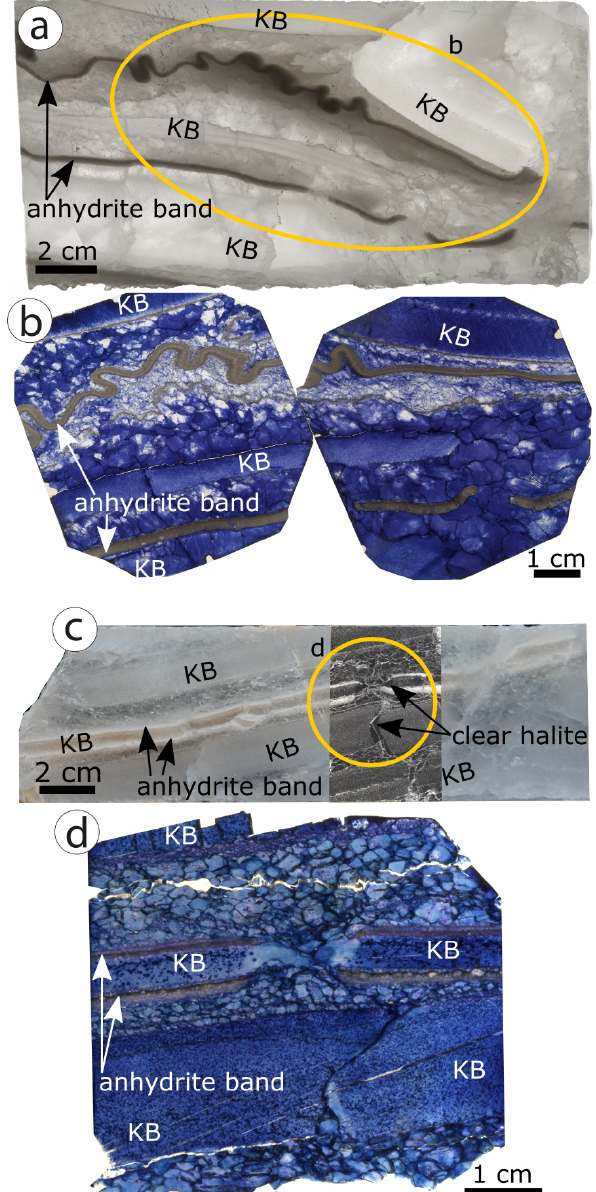
Figure 4. (a) Transmitted-light salt core slab (Zuidwending) show- ing Kristallbrocken (KB), folded 3mm thick anhydrite band in a fine-grained halite matrix, and unfolded but boudinaged 3mm thick anhydrite band next to Kristallbrocken. (b) Gamma-irradiated transmitted-light scan (samples KS-13A and B) location indicated in (b) showing white cores and blue growth rims in fine-grained halite. (c) Salt core slab photograph of Pieterburen slab and photo- montaged transmitted-light image of thick section showing Kristall- brocken (KB) with clear halite on the grain edges of Kristallbrocken grains (modified after Sadler, 2012). (d) Transmitted-light scan of gamma-irradiated sample BS-A showing lighter-blue cores and dark-blue growth rims in a fine-grained halite